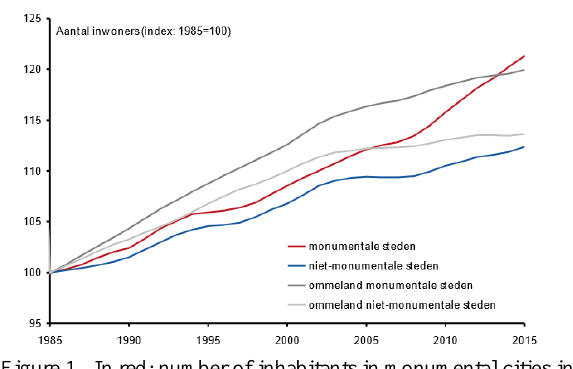
Figure 1. In red: number of inhabitants in monumental cities in the Netherlands. (Marlet, 2016a)